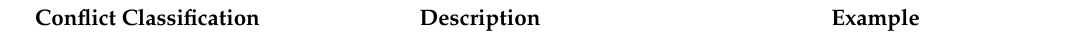
Table2. Threetypesofterritorialconflicts, accordingtostatusinordertomaintainterritorialconnectivity and the delivery of ecosystem services of the matrix that makes up the